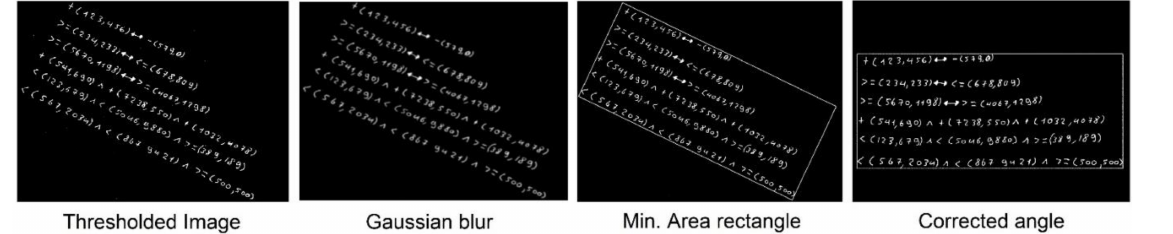
Figure 3. Example of text area